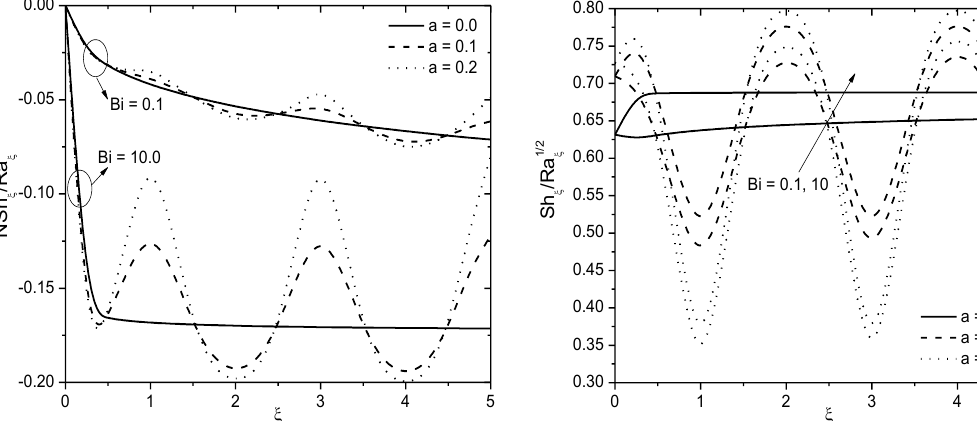
Figure 14. Effects of Bi and a on local nanoparticle Sherwood number